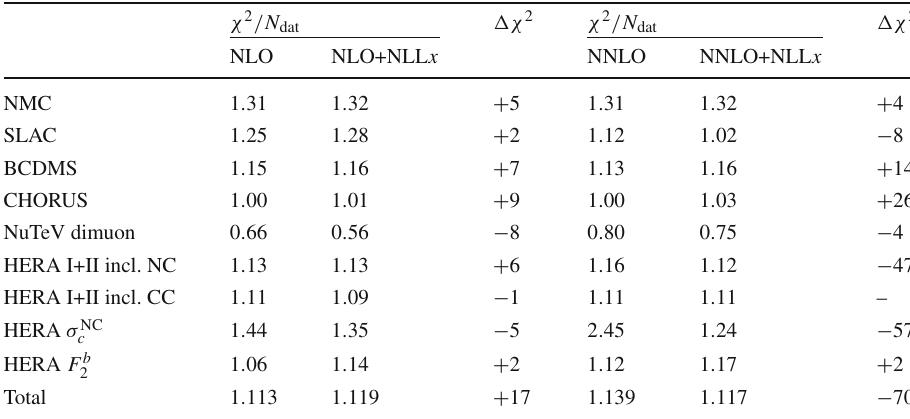
Table 3 The values of χ 2 / N dat for the total and the individual datasets included in the DIS-only NNPDF3.1sx NLO, NLO+NLL x , NNLO and NNLO+NLL x fits. The number of data points N dat for each experiment is indicated in Table 1. In addition, we also indicate the absolute difference (cid:6)χ 2 between the resummed and fixed-order results, Eq. (4.1). We indicate with a dash the case | (cid:6)χ 2 | < 0 .